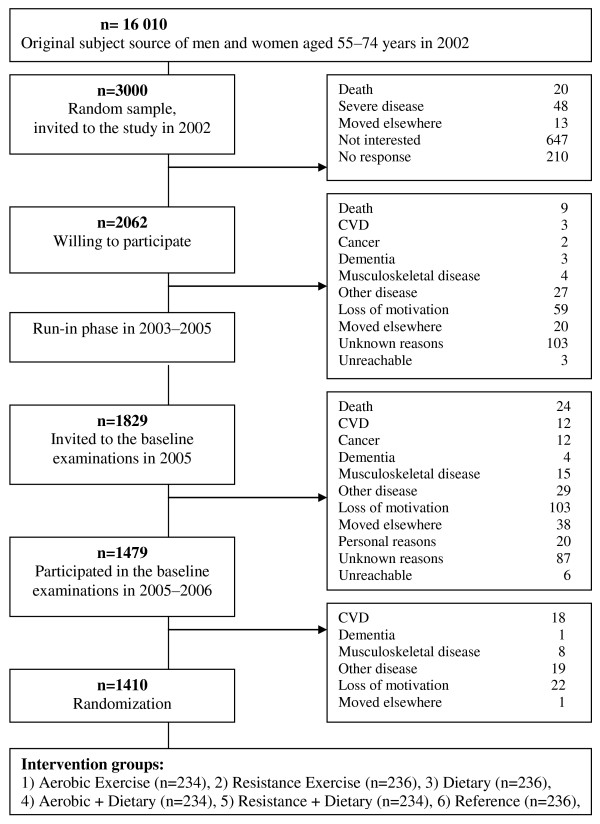
Study design at DR's EXTRA study.